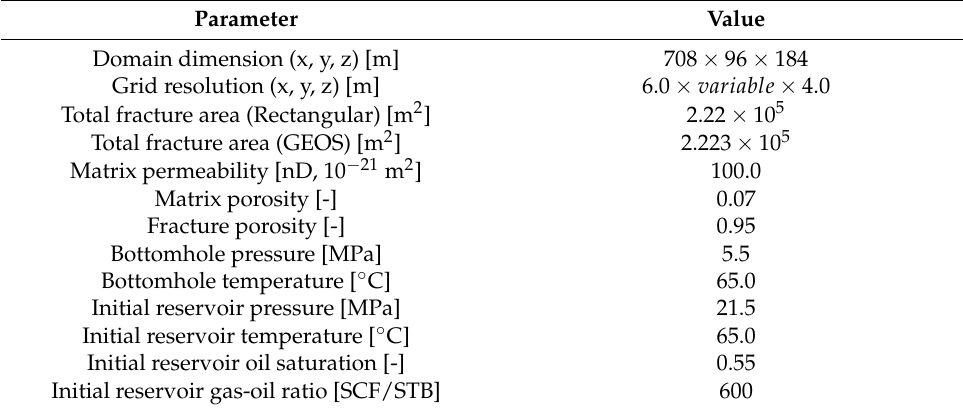
Table 1. Parameters used for production simulation.